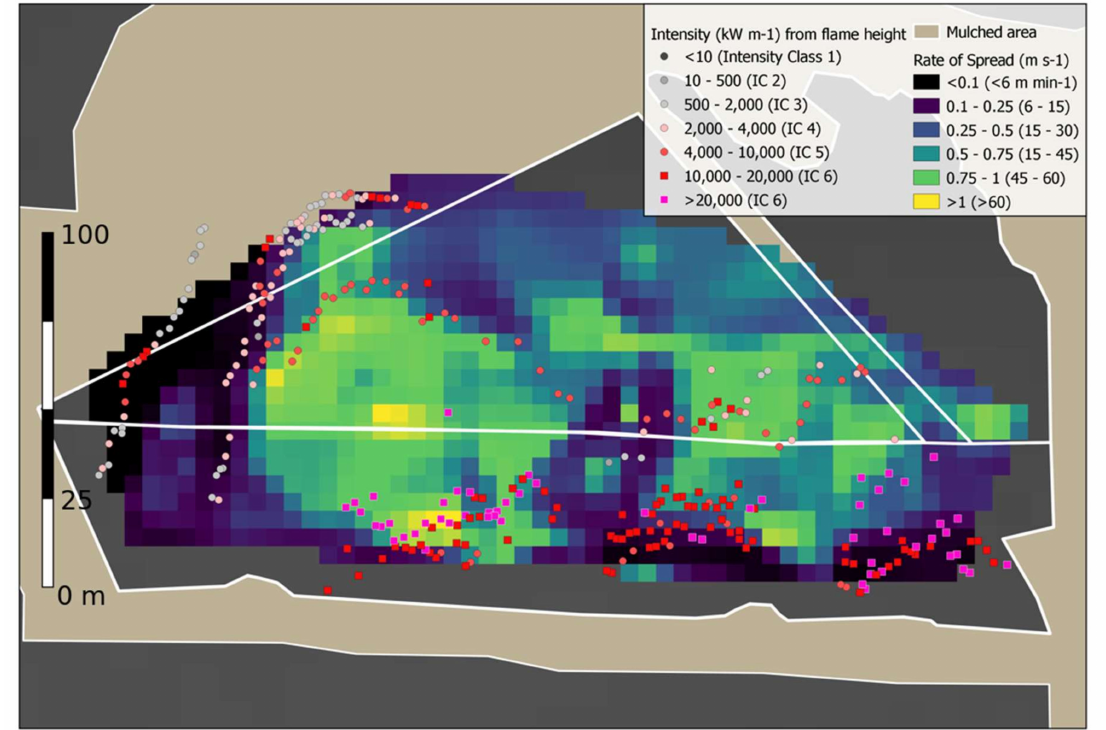
Figure 8. Fire intensity inferred by flame height from oblique aerial photography. Note that limited photographs were available to capture the flame heights, so large gaps between points